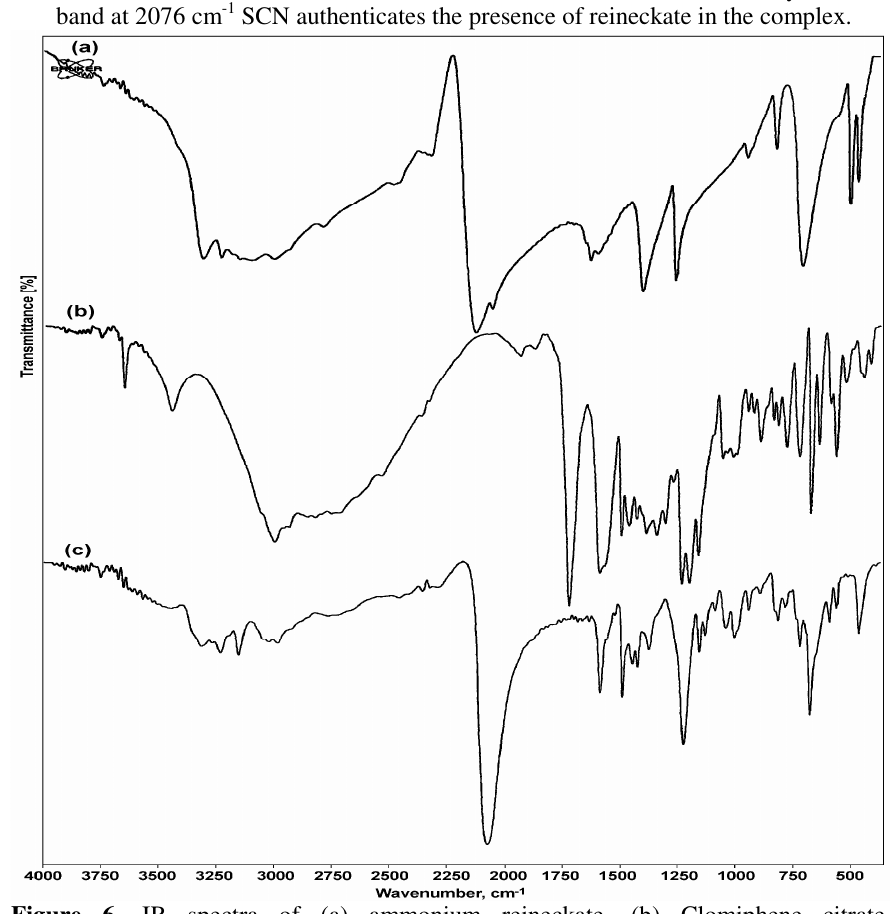
Figure 6. IR spectra of (a) ammonium reineckate, (b) Clomiphene citrate and (c) Clomiphene citrate and ammonium reineckate